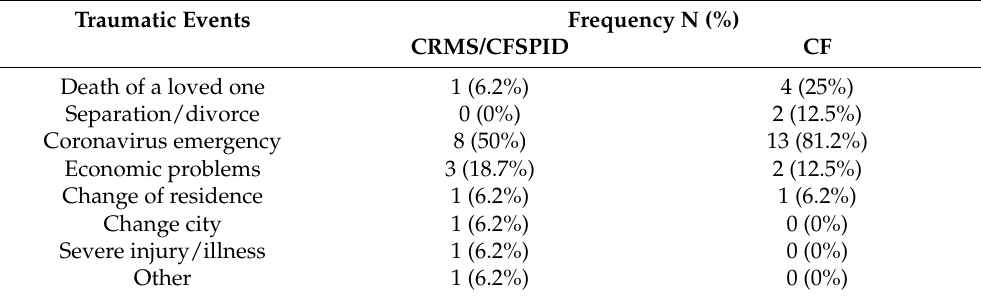
Table 2. Traumatic events in the 12 Months preceding the interview in CRMS/CFSPID and CF patient parents.